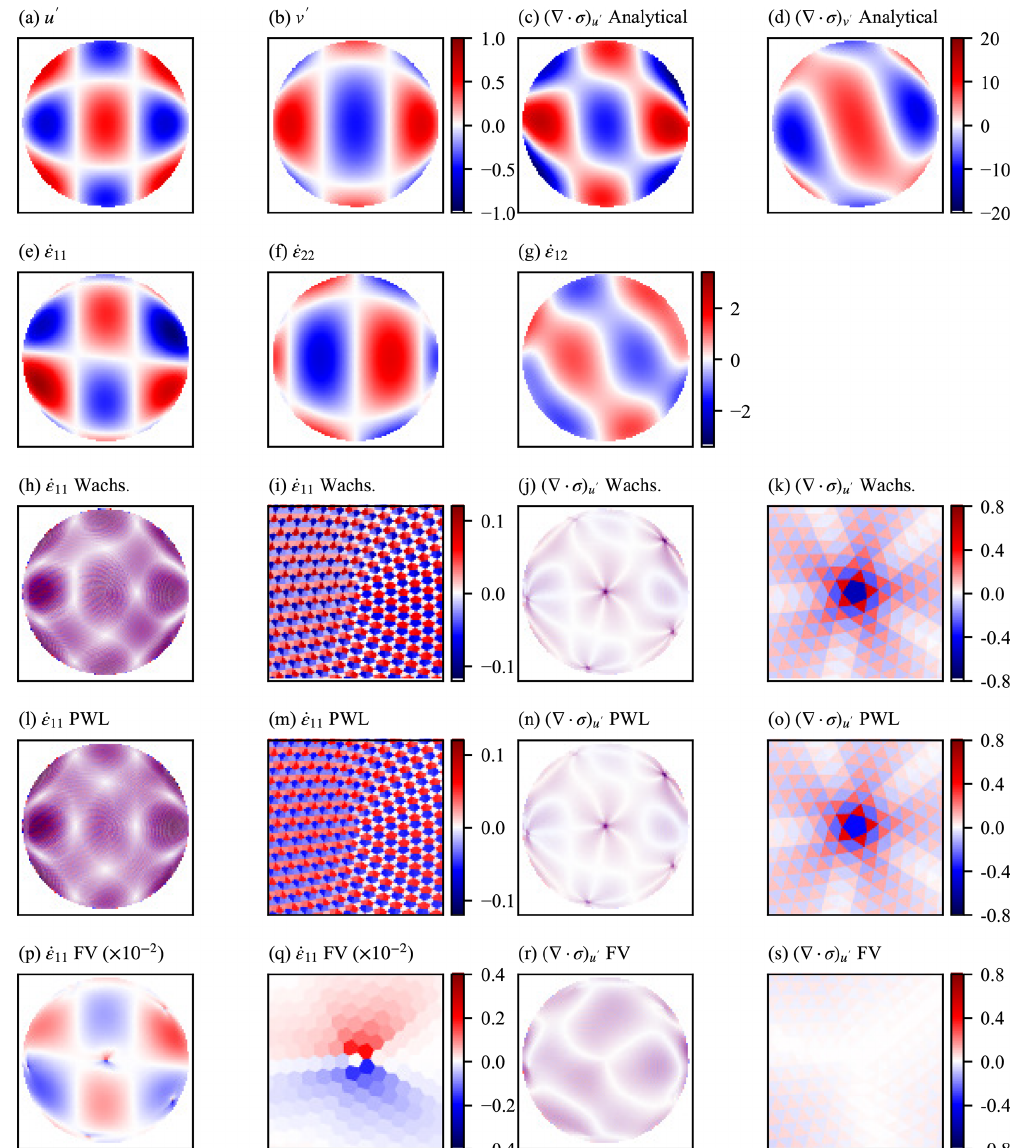
Figure 7. Orthographic projection of one hemisphere of the unit sphere test case described in Sect. 3.1.2. Panels (a) and (b) show the analytical forms of velocity used in the numerical schemes and used to calculate the desired analytical strain rates (shown in e–g ) and the desired analytical stress divergence (shown in c and d ). Panels (h) , (i) , (l) , (m) , (p) , and (q) show the error in calculation of the ˙ (cid:15) 11 component of the strain rate for the (h, i) Wachspress variational scheme, the (l, m) PWL variational scheme, and the (p, q) finite-volume (FV) scheme. Panels (j) , (k) , (n) , (o) , (r) , and (s) show the error in calculation of the u component of the stress divergence for the (j, k) Wachspress variational scheme, the (n, o) PWL variational scheme, and the (r, s) finite-volume (FV) scheme. Detail is shown around one of the pentagonal mesh cells for each scheme in (i) , (k) , (m) , (o) , (q) , and (s) . The error is the difference between the model and analytical